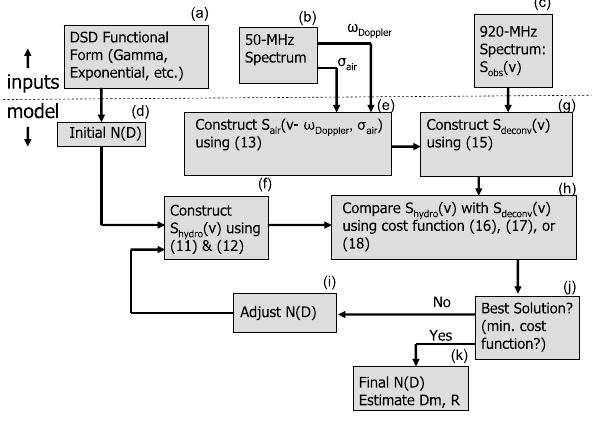
Fig. 2. Deconvolution method flow diagram.